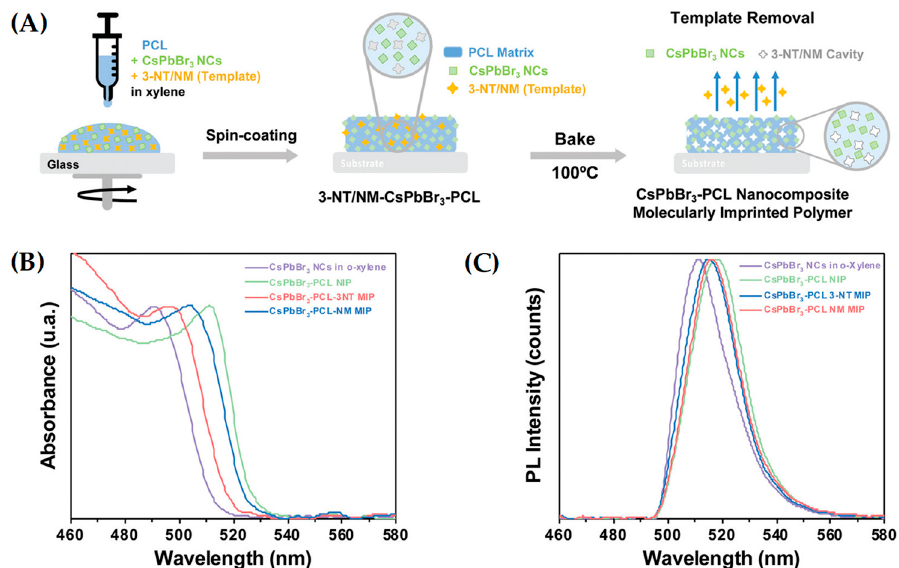
Figure 12. ( A ) Steps in the fabrication of the CsPbBr 3 –PCL 3-NT or NM MIP sensor; ( B ) UV-vis absorbance spectra and ( C ) emission spectra of CsPbBr 3 NCs in o-xylene (purple line) and embedded in the PCL polymer matrix without (green line) and with a 3-NT (blue line) or NM (red line) template. Reprinted from [50], with permission from Royal Society of Chemistry, 2022 (https://pubs.rsc.org/en/content/articlehtml/2022/tc/d1tc05169e (accessed on 16 December 2022)).